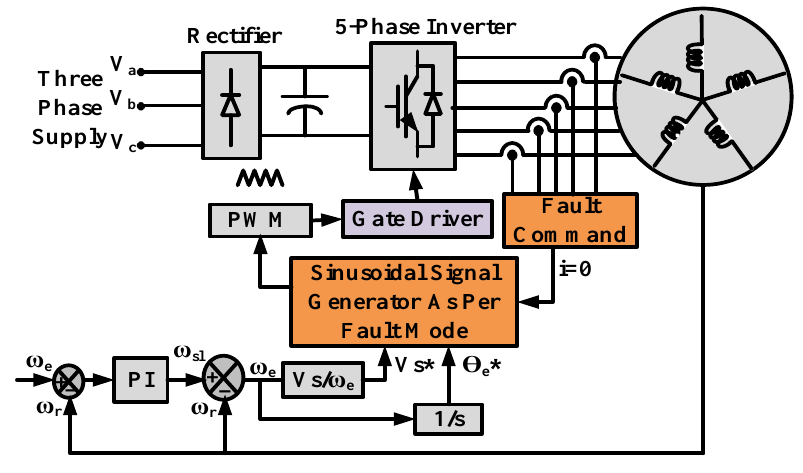
Figure 3. Block diagram of fault-tolerant control strategy.